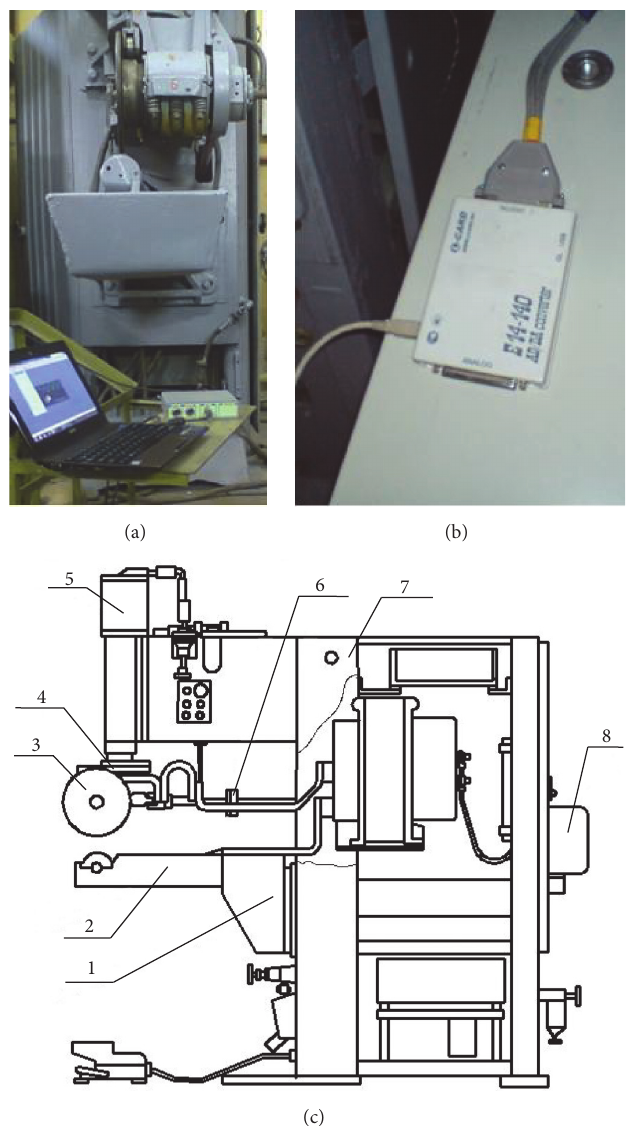
Figure 13: General view of the installation for experimental investigation (a, b), the basic scheme of equipment for electric contact surfacing (c) (1: bottom bracket, 2: cantilever, 3: roller electrode, 4: intermediate plate, 5: slider for drive efforts, 6: articulated shaft, 7: casing wall, and 8: the rotary